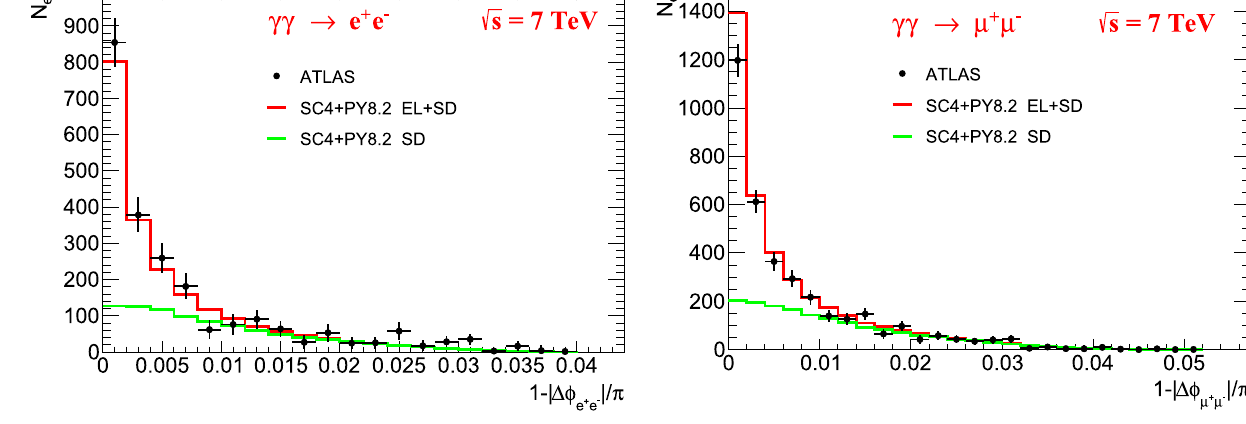
region. Electron (muon) pair production is shown in the left (right) fig- ures. The elastic and SD contributions are overlaid, while the DD has been subtracted from the data, and so is not